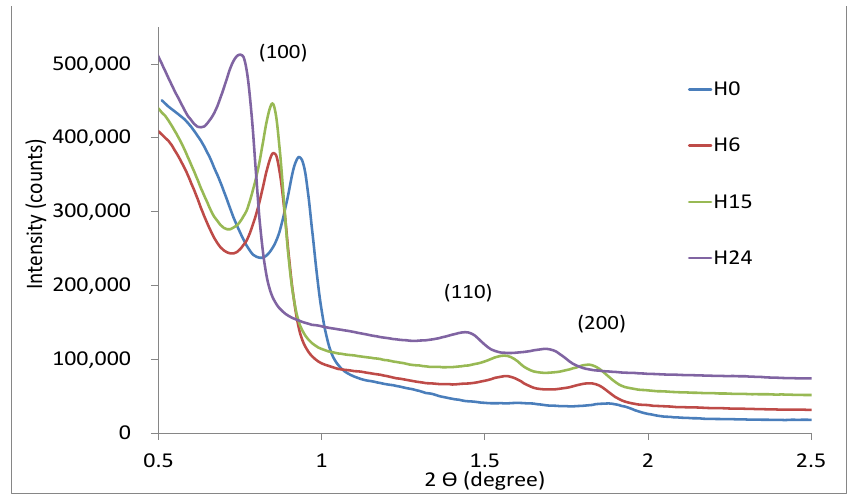
Figure 3. XRD spectra of the samples prepared at different hydrothermal treatment times (samples H6, H15 and H24 are offset vertically by 20,000, 40,000 and 60,000 counts, respectively).